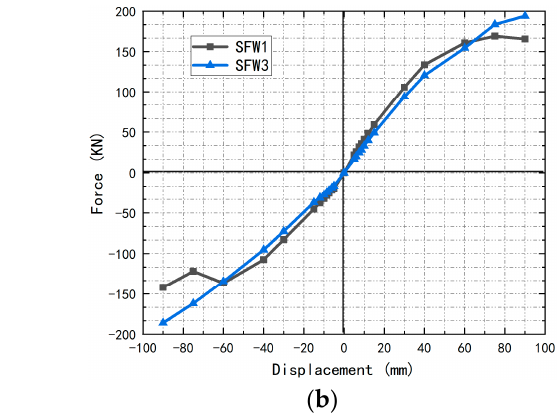
Figure 11. Hysteric curves of SFW1 ( a ), SFW2 ( b ) and SFW3 ( c ).